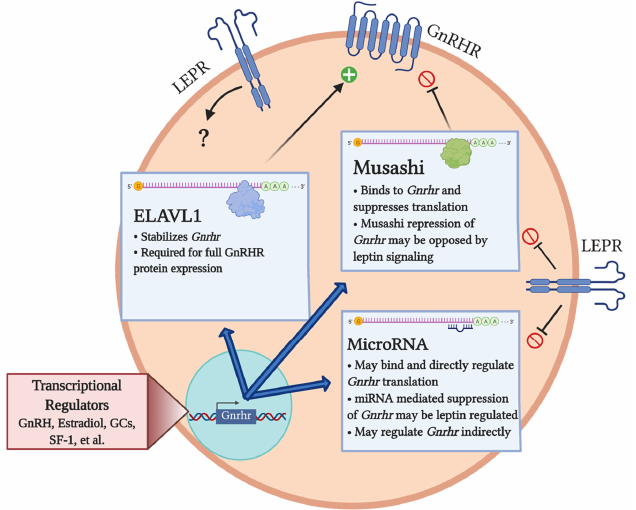
Figure 1. Post-transcriptional control of Gnrhr and the role of leptin. The proposed mechanisms for post-transcriptional control of Gnrhr are depicted, with leptin negatively regulating Musashi and microRNAs. The role of leptin in the regula- tion of ELAVL1 (if any) is unknown. Abbreviations: embryonic lethal abnormal vision like 1 (ELAVL1), leptin receptor (LEPR), glucocorticoids (GCs), steroidogenic factor-1 (SF-1). 3. Post-Transcriptional Regulation of Gnrhr Discreet GnRH pulses increase the numbers of GnRH receptors in gonadotropes